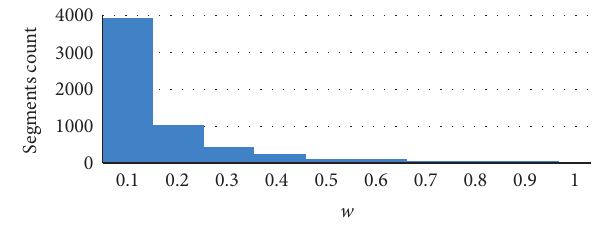
Figure 7: EB weight ( w )